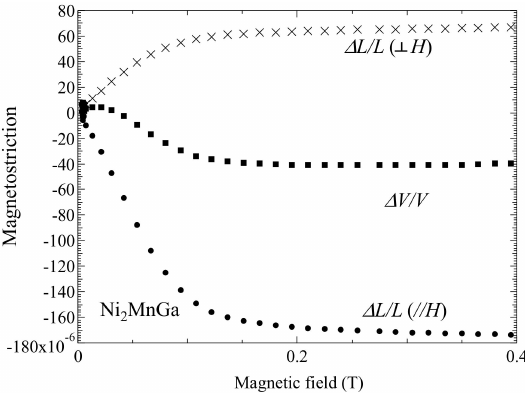
Figure 7. Magnetic field dependence of the magnetostriction at T = 251 K in the premartensitic phase.